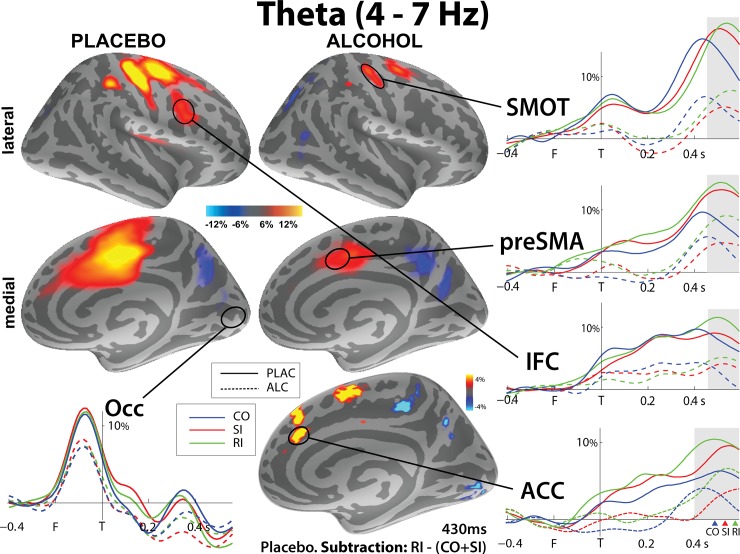
Group-average maps of event-related theta source power estimates and the associated timecourses, expressed as percent change from pre-flanker baseline.‘F’ and ‘T’ correspond to flanker (at -200 ms) and target (0 ms) presentation respectively and colored arrows mark average reaction times for CO, SI and RI respectively. Gray windows highlight the peak activity across ROIs (450-600ms for most ROIs and 400-600ms for ACC to account for earlier activation to RI). Under placebo, sensorimotor cortex (SMOT) and pre-supplementary motor area (pre-SMA) show higher theta to both types of incongruity, while right inferior frontal cortex (IFC) and anterior cingulate cortex (ACC) are especially responsive to RI trials. Alcohol abolished sensitivity to both types of incongruity in SMOT, but retained higher theta to response incongruity in pre-SMA. Theta increase to RI trials was abolished in the IFC under alcohol, but preserved in the ACC.